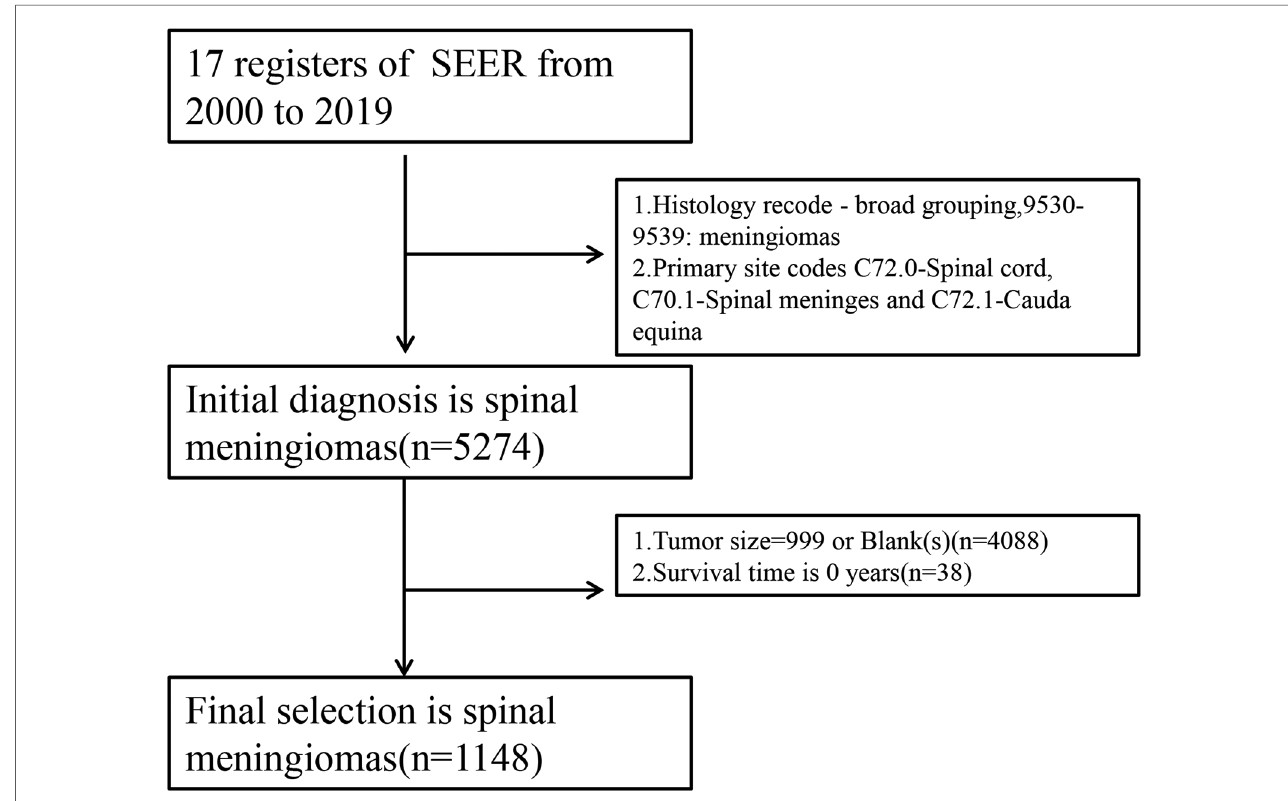
FIGURE 1 Flowchart of the analysis of spinal